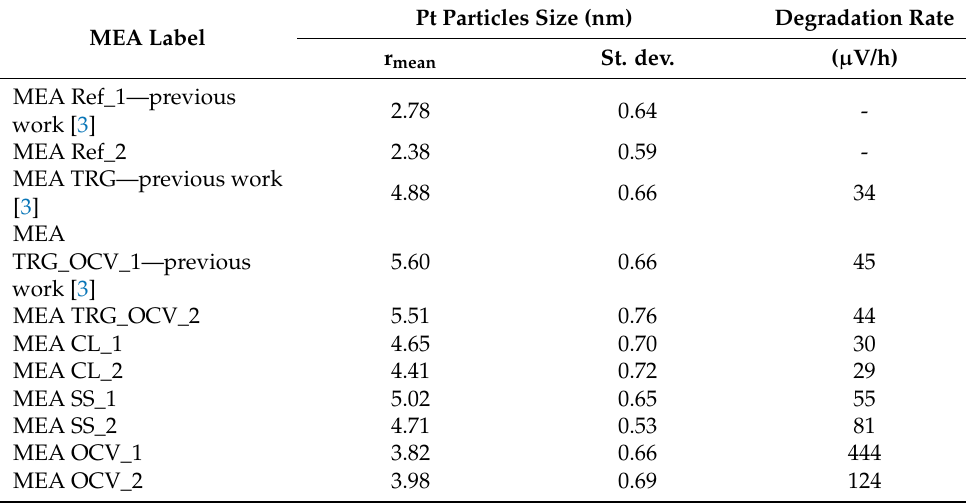
Table 3. Degradation rate values and mean catalyst Pt particles radii of tested MEAs obtained with the SAXS